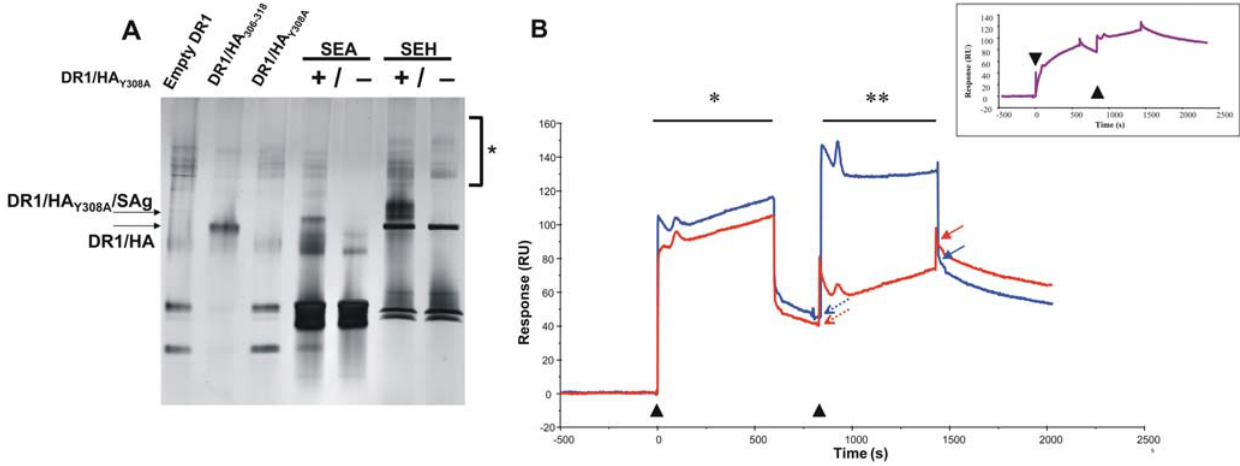
Figure 1. SEA and SEH bind HLA-DR1 in solution. (A) SEA-DR1 and SEH-DR1 complexes are SDS stable. Various Enterotoxins in the presence or absence of HLA-DR1/peptide complexes were incubated in PBS with a final SDS concentration of 0.1%, for 5 min at room temperature and subjected to electrophoresis in a 12% polyacrylamide gradient gel. The gel was silver stained by standard protocols. There was no evidence of multimer formation (*) Lane 1 : empty DR1. Lane 2 : DR1/HA 306-318 complex. Lane 3 : DR1/HA Y308A complex. Lane 4 : SEA + DR1/HA Y308A Lane 5 : SEA only Lane 6 : SEA + DR1/HA Y308A Lane 7 : SEH only. (B) SEA-DR1 but not SEH-DR1 complexes can bind an additional DR1 . A solution of DR1 was injected on a HA 306-318 peptide decorated BIAcore CM5 chip (*) and allowed to dissociate for 3 minutes. A second injection (**) of preformed SEA-DR1 ( red ) resulted in a 30% greater RU change than SEH-DR1 ( blue ), as measured by the difference between the solid and dashed arrows. Two consecutive injections of DR1 alone on a control flow cell (inset) showed the same fold increase in RUs as SEH-DR1. m , start of injection.